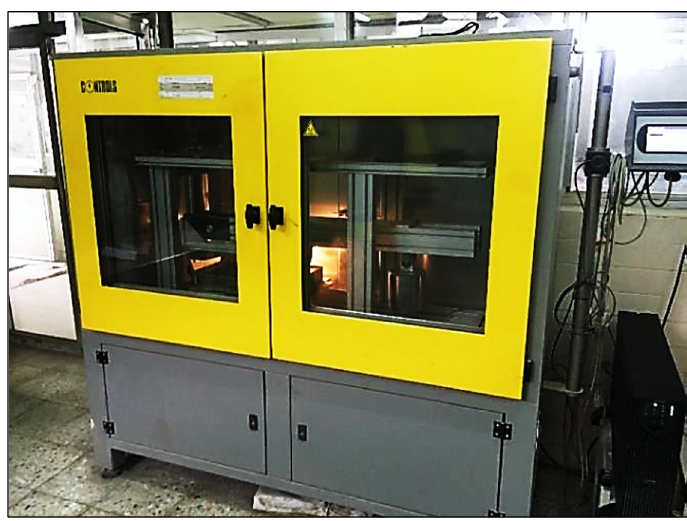
Figure 12. Wheel-track apparatus.